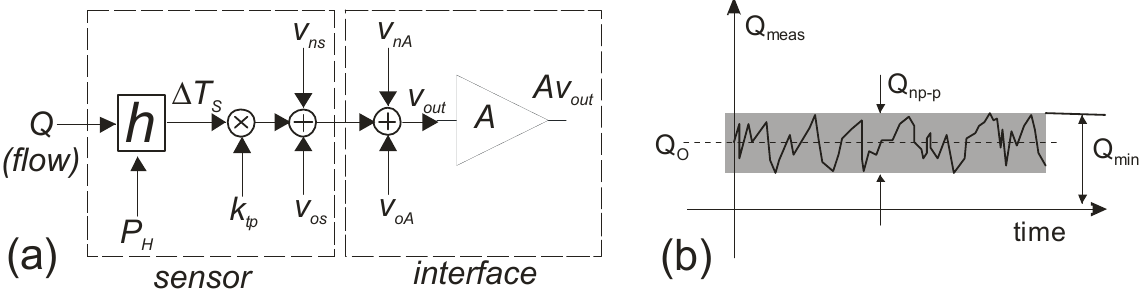
Figure 2. ( a ) Signal flow path representation of the transduction mechanism, with the main non-idealities indicated; ( b ) Effect of the offset and noise on the sensor detection limit. Q is the flow sensor reading under still fluid meas